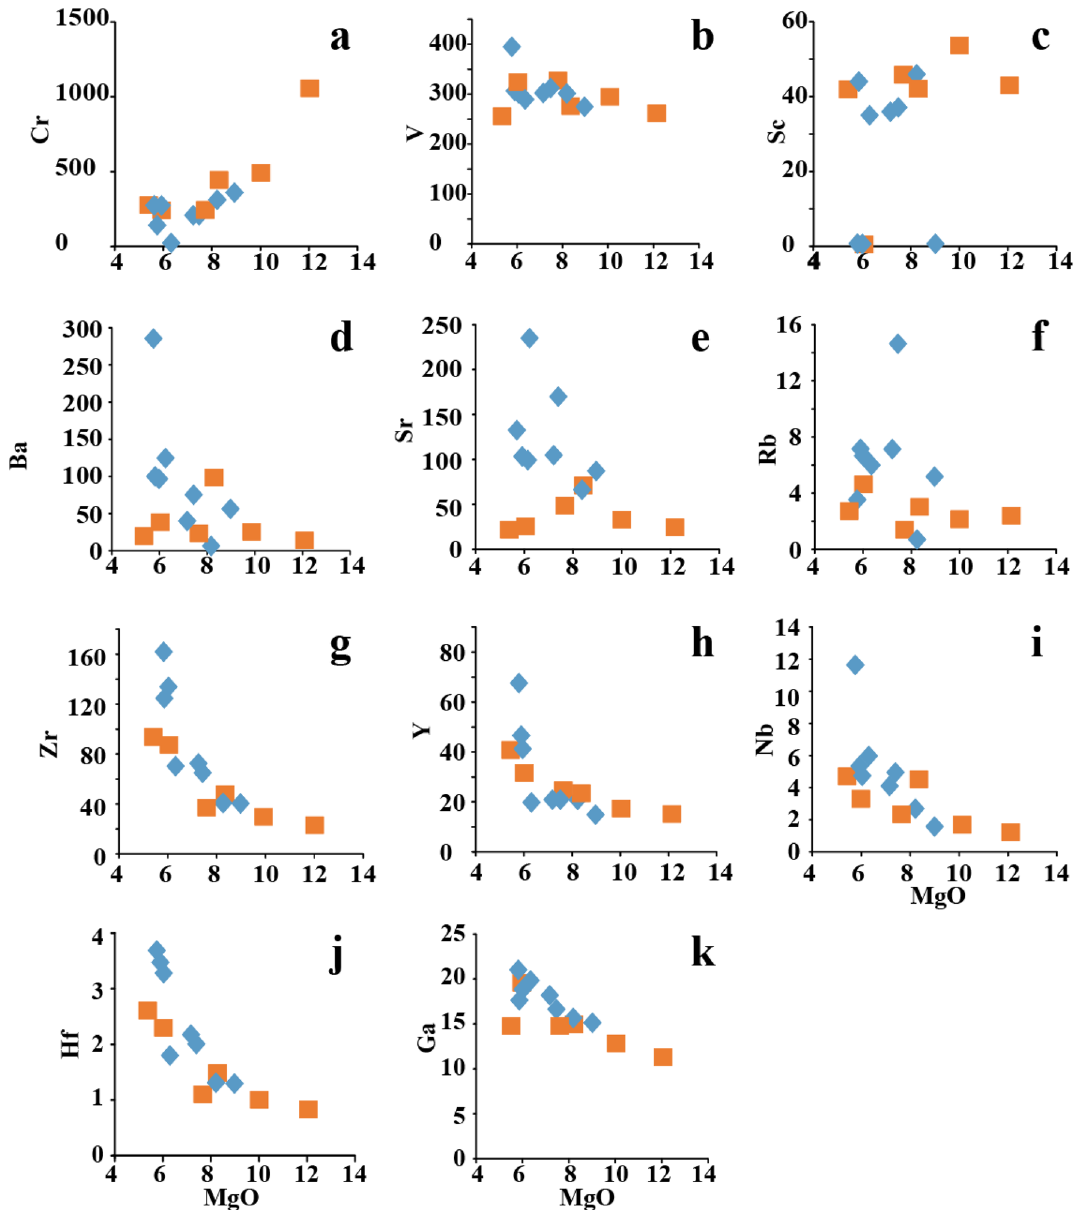
Fig. 11 Binary plots highlighting the HSFE relations with MgO. Symbols are the same as in Fig.